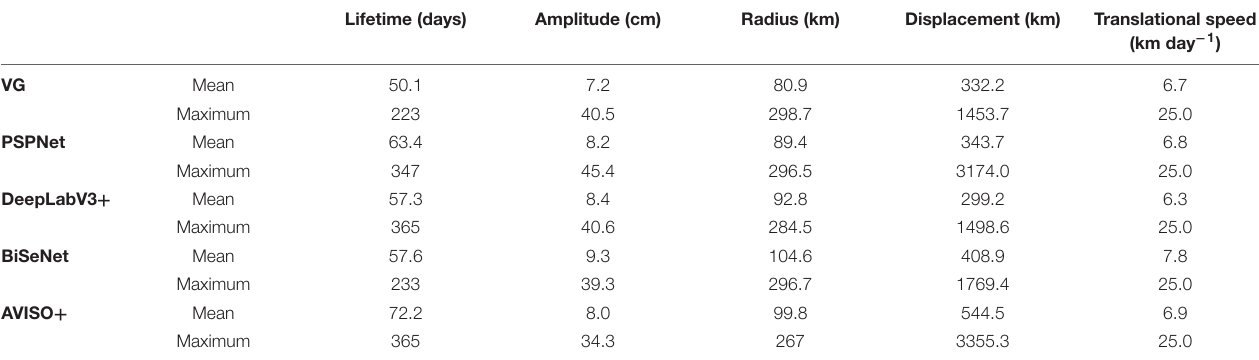
TABLE 1 | Comparisons of eddy properties base on the five